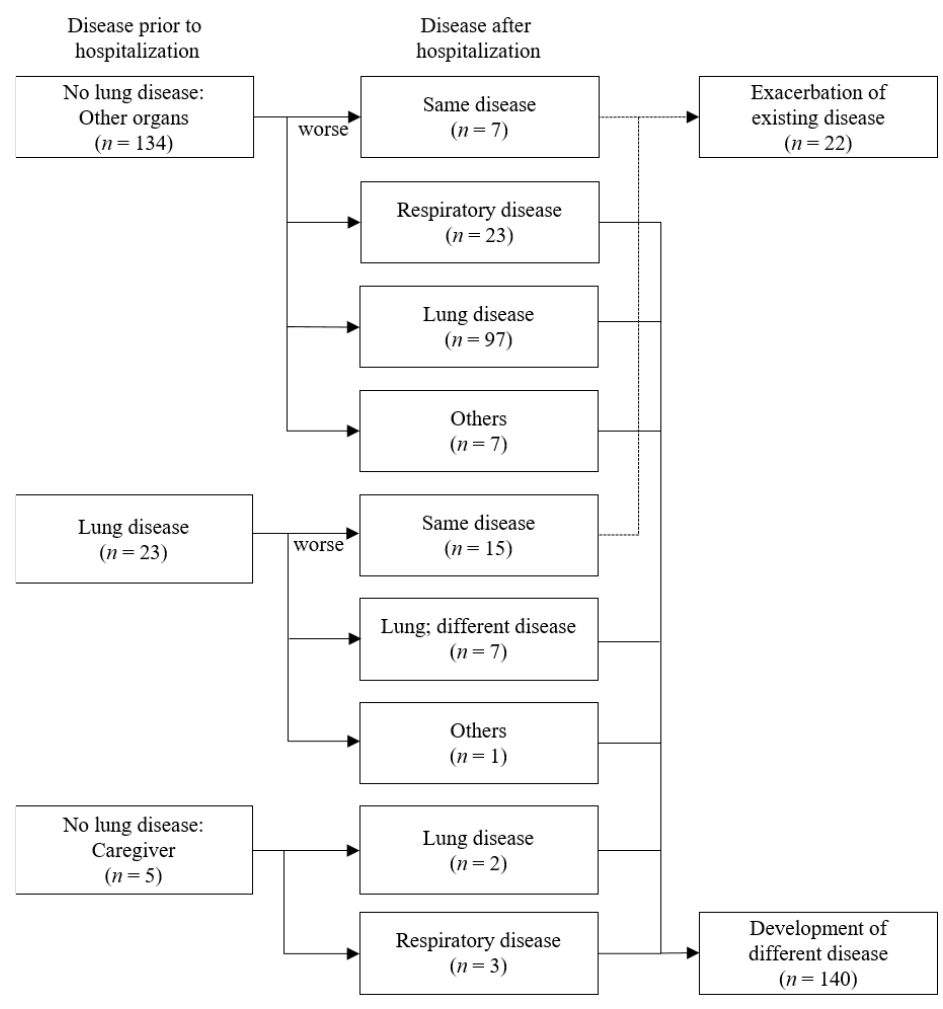
Figure 3. Changes in disease status before and after hospitalization. Table 1. Characteristics of participants ( n = 162).